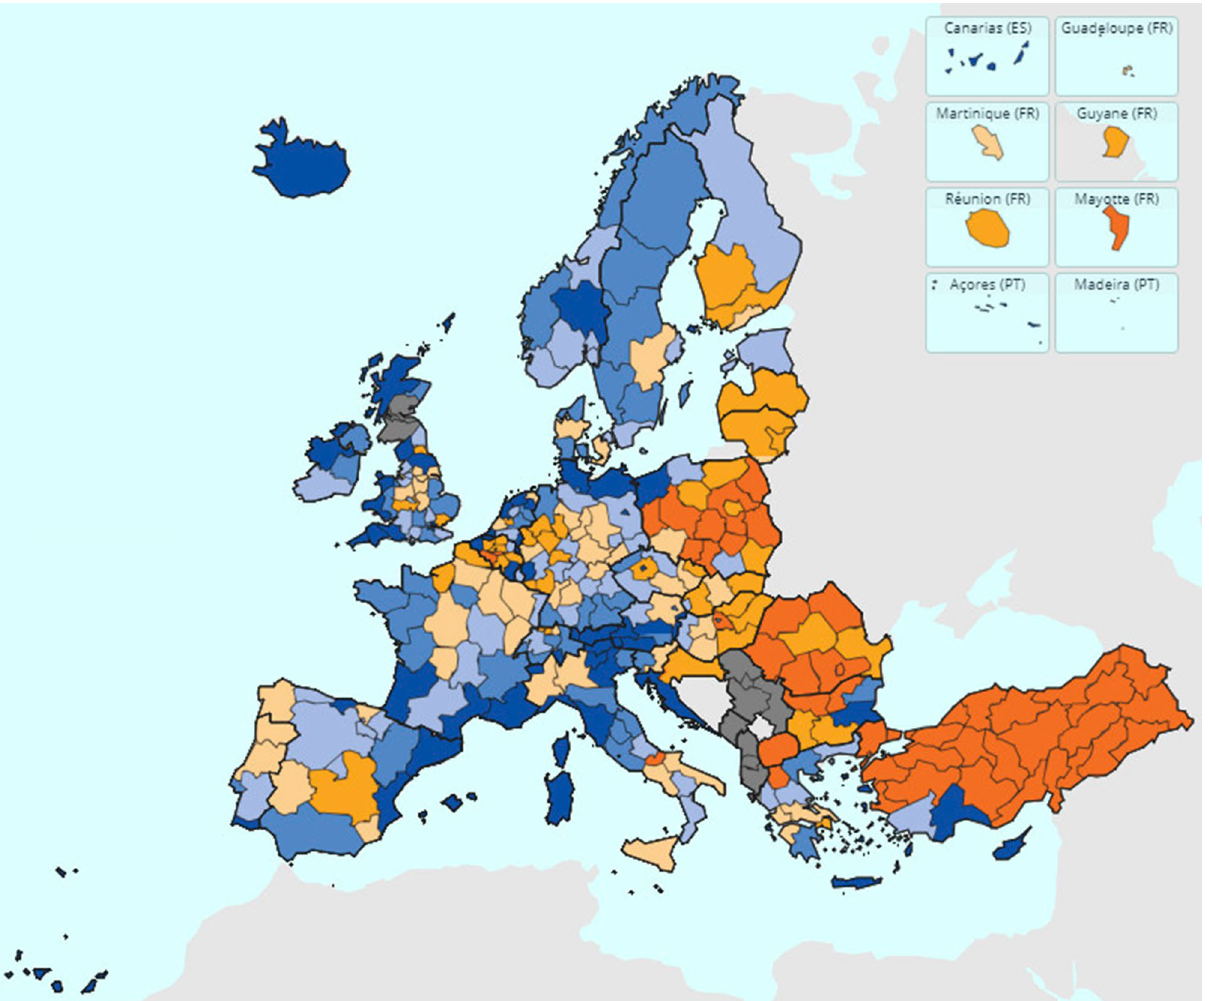
Figure 1. Map showing the EU NUTS2 regions colored by their tourism dependence. Regions in blue are those with the highest tourism dependence while regions in orange have the lowest tourism dependence. If tourism information is not available, the region is colored in gray. Source: